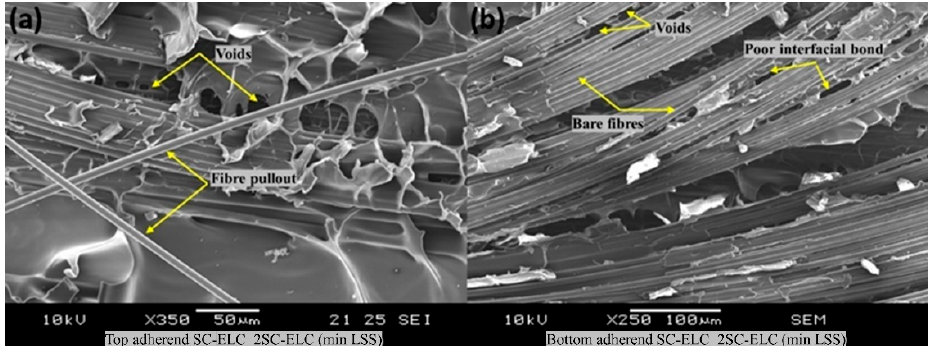
Figure 23. SEM fractography of 2SC-ELC_SC-ELC for minimum LSS (a) represents the fractured of the top adherend showing voids an fibre pull-out ( b ) represents the fractured surface of the bottom surface of the top adherend showing voids an fibre pull-out (b) represents the fractured surface of the adherend showing voids, bare fibers, and poor interfacial bottom adherend showing voids, bare fibers, and poor interfacial bond.